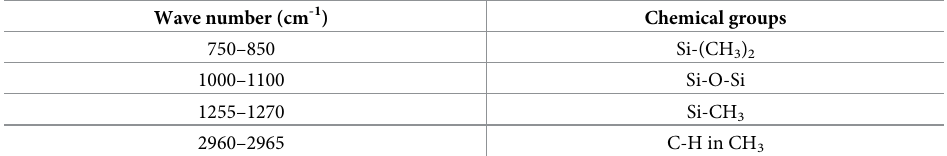
Table 3. Appropriate wave numbers of chemical groups.